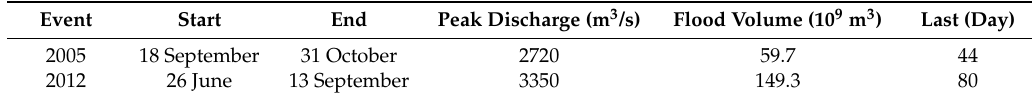
Table 4. Basic data of the two selected flood events.